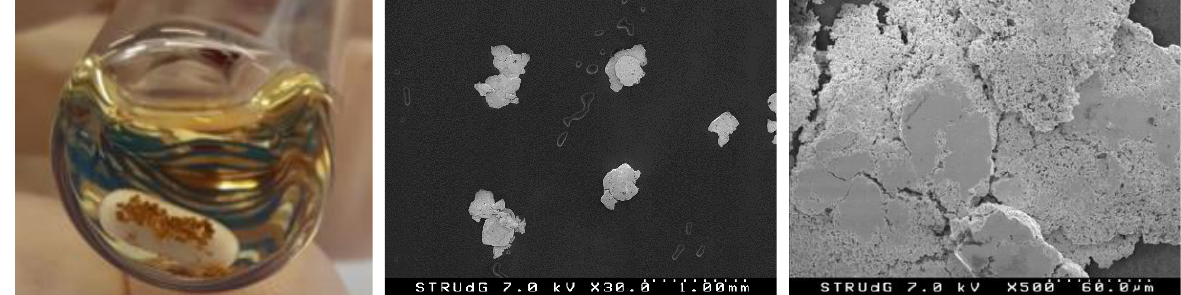
Figure 5. Reaction outcome with Au(0) precipitate ( left ), and SEM images of the isolated Au(0) nuggets at ×30 and ×500 ( middle and right ), from the reaction employing complex 1 (1 eq), AgOAc (1 eq) and PhI(OAc) 2 (2 eq) in 1,2-DCE, at 90 °C overnight, under N 2 atmosphere in the absence of light (Table 1, entry 1).